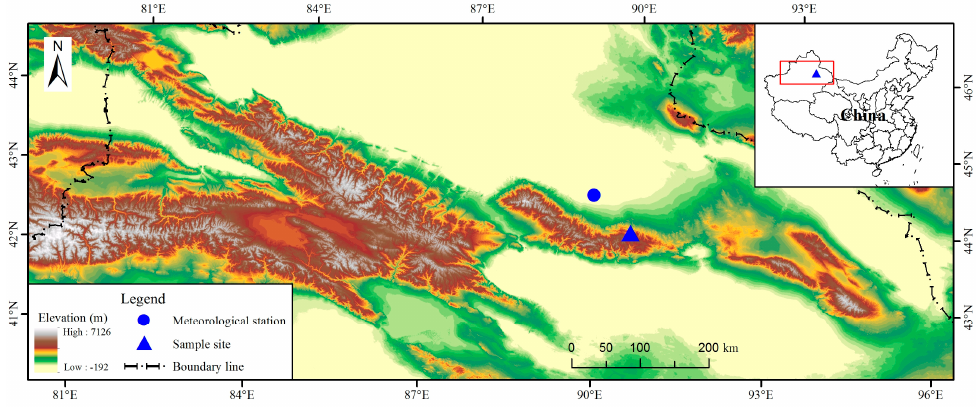
Figure 1. Locations of the study area and the nearest meteorological station (Tianshan Mountains).